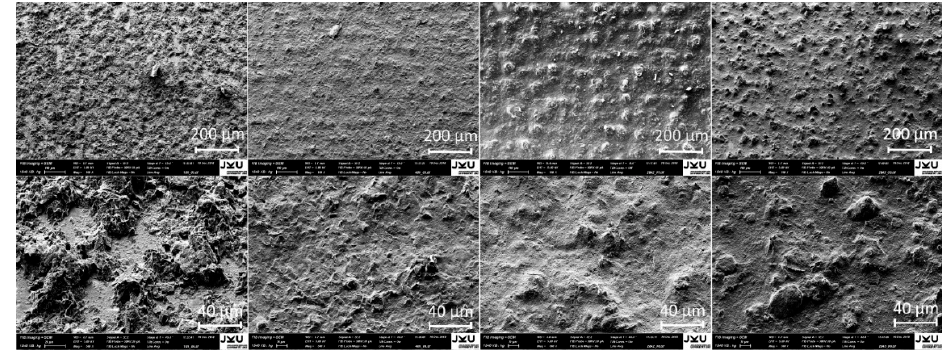
Figure 3. Scanning Electron Microscope (SEM) images of the printed inks. From left to right: inks 109, 406, 2842, and 2843. An image with a lower ( top ) and a higher ( bottom ) magnification was made of each ink.